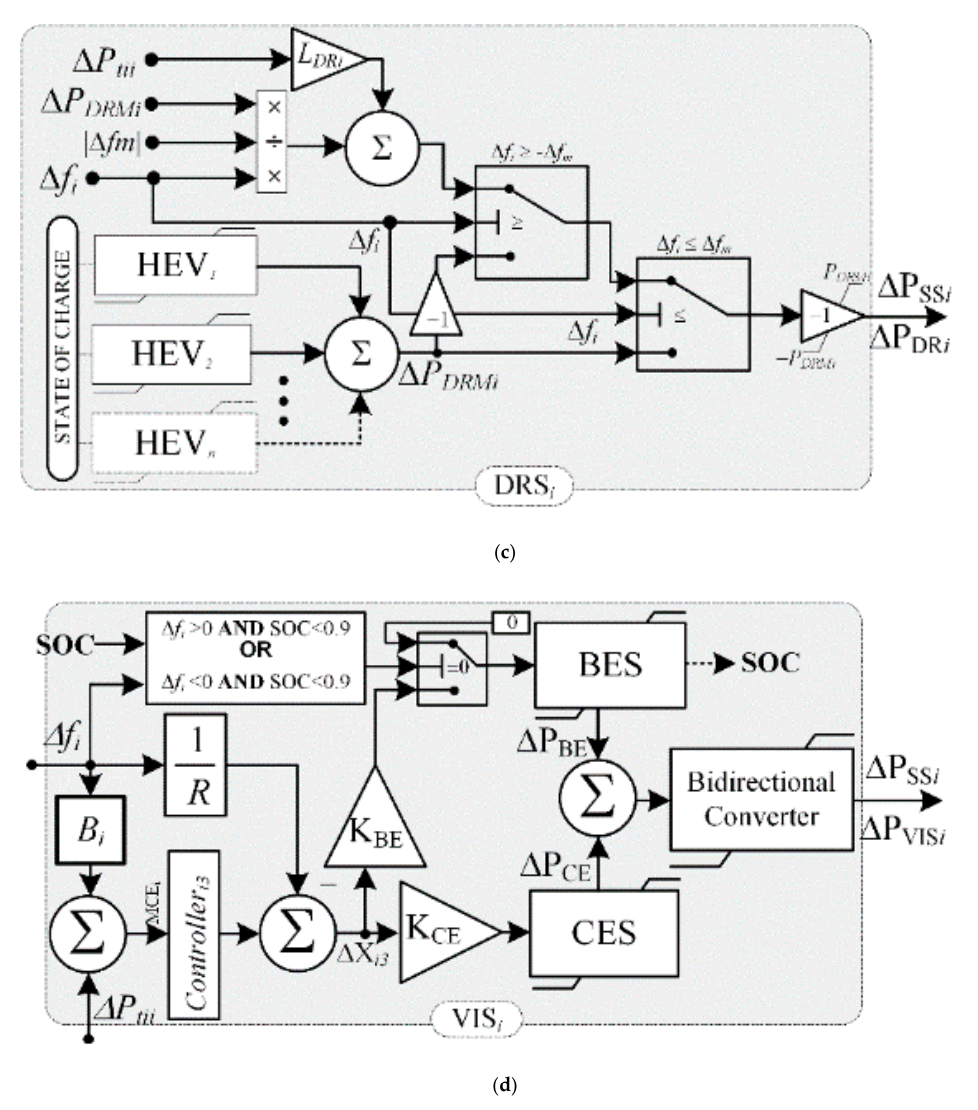
Figure 3. Simulink models: ( a ) interconnected microgrids, ( b ) model of AVR unit, ( c ) model of DRS unit, and ( d ) model of VIS unit.